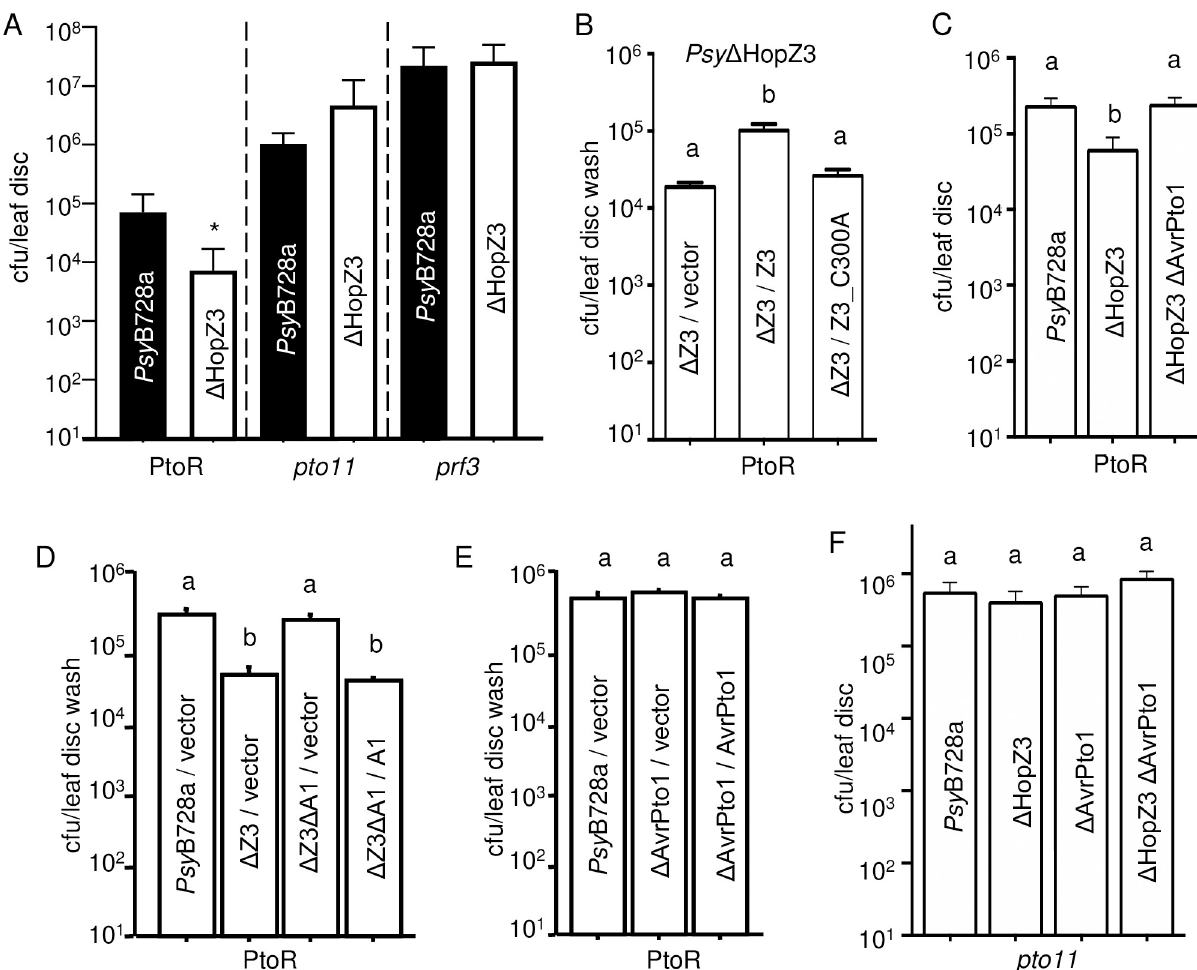
Fig 1. HopZ3 promotes the growth of Psy B728a on PTO-containing tomato plants (PtoR) and suppresses defenses triggered by AvrPto1 Psy . Plants were spray inoculated with Ps yB728a-derived strains at an OD 600 = 0.01 and total (epiphytic + endophytic) or epiphytic bacterial populations were quantified in 8 leaf discs or leaf disc washes, respectively. (A) Total bacterial populations of Ps yB728a and Psy Δ HopZ3 were different in PtoR but were not statistically different in pto11 and prf-3 plants after 4 days (n = 8, t-test � P < 0.05). (B) HopZ3 (Z3), but not the catalytic mutant (Z3_C300A) complements the low growth phenotype of Psy Δ HopZ3 in PtoR tomato. (C-D) Deletion of AvrPto1 Psy ( Δ A1) from Psy Δ HopZ3 ( Δ Z3) restores total (C) and epiphytic (D) bacterial growth to WT ( Psy B728a or Psy B728a/vector) levels in PtoR tomato. (E) Deletion of AvrPto1 affect bacterial growth in PtoR tomato. (F) AvrPto1 Psy does not confer resistance in pto11 plants, regardless of the presence of HopZ3. For (B,D,E) epiphytic bacteria were collected by leaf disc washes five (B) or four (D-E) days after inoculation. Different letters indicate significant differences in growth as assessed by ANOVA with Tukey’s test (P < 0.0002) or Fisher’s test P < 0.0001, n = 8). For C and F, total bacteria were quantified 3 days after spray inoculation. Different letters indicate significant differences in growth (n = 8, ANOVA with Tukey’s test, P < 0.05). All experiments were repeated at least twice with similar results. Bars indicate standard